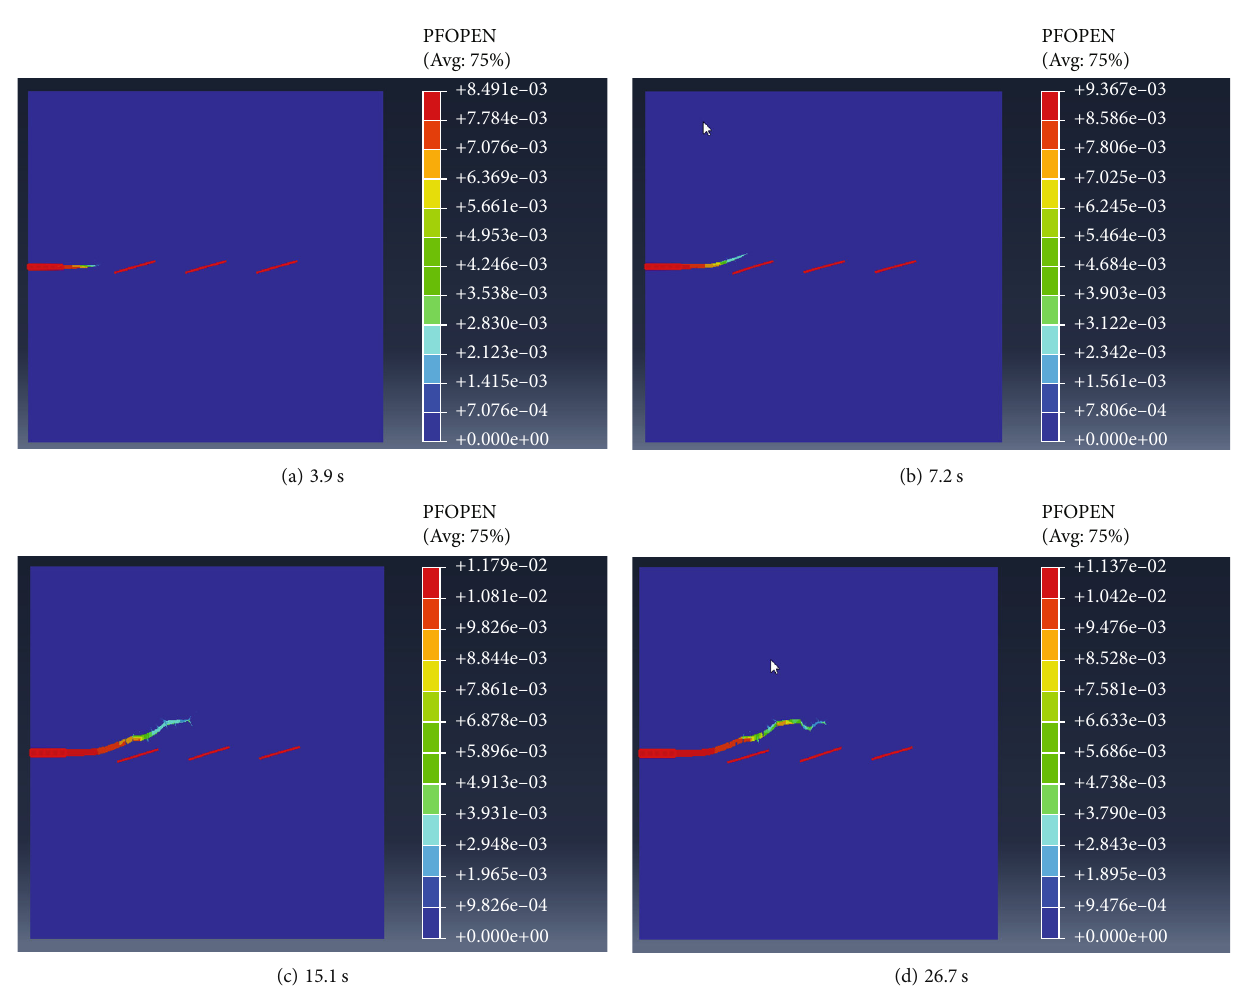
Figure 13: HF propagation at the NF approaching angle of 30 ° and stress anisotropy coe ffi cient of 0.1.